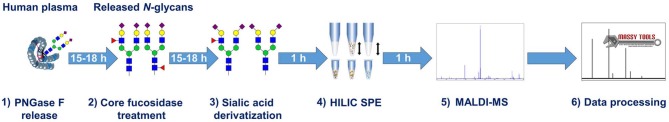
Workflow of the antennary fucose assay for human plasma.